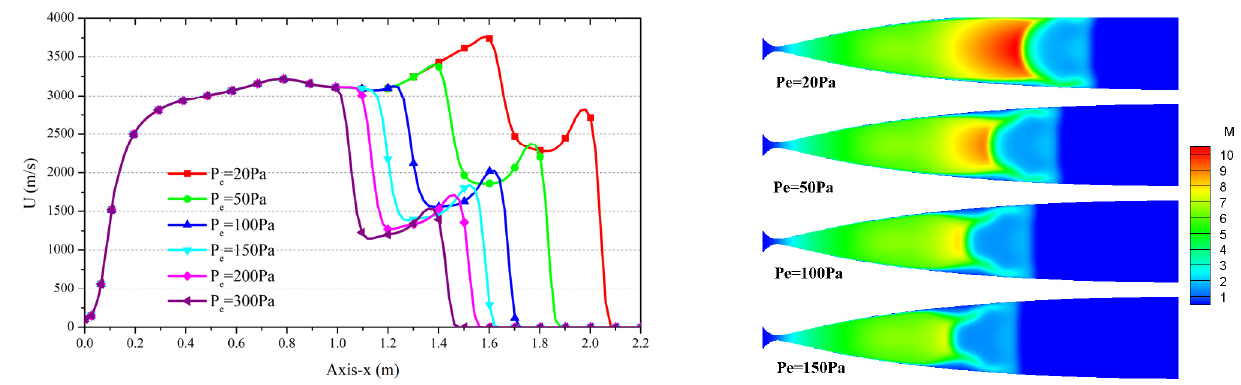
Figure 7. Velocity distribution of nozzle axis ( left ) and Ma contour ( right ) in different initial pressure at 0.5 ms.